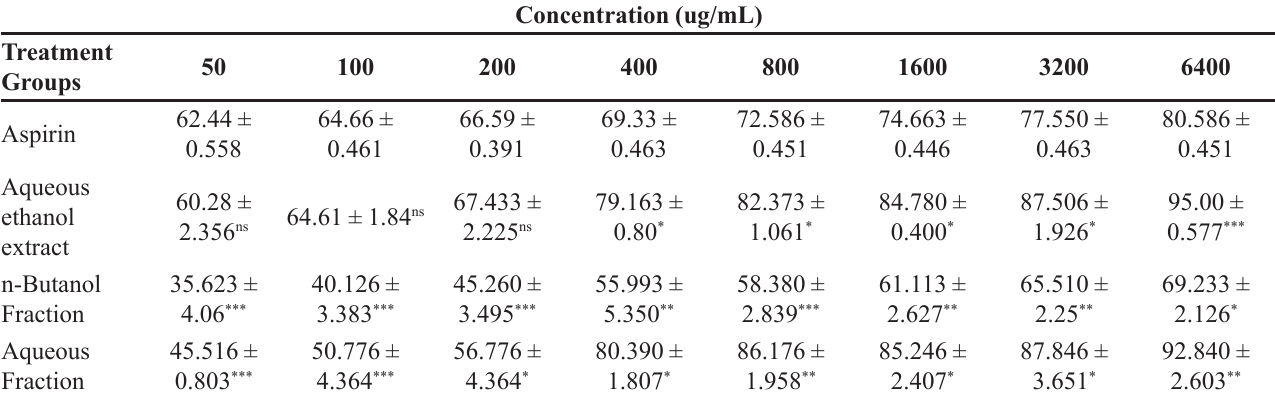
TABLE I - Effect of Ribes alpestre on inhibition of protein (bovine serum albumin) denaturation Percentage protection against protein denaturation